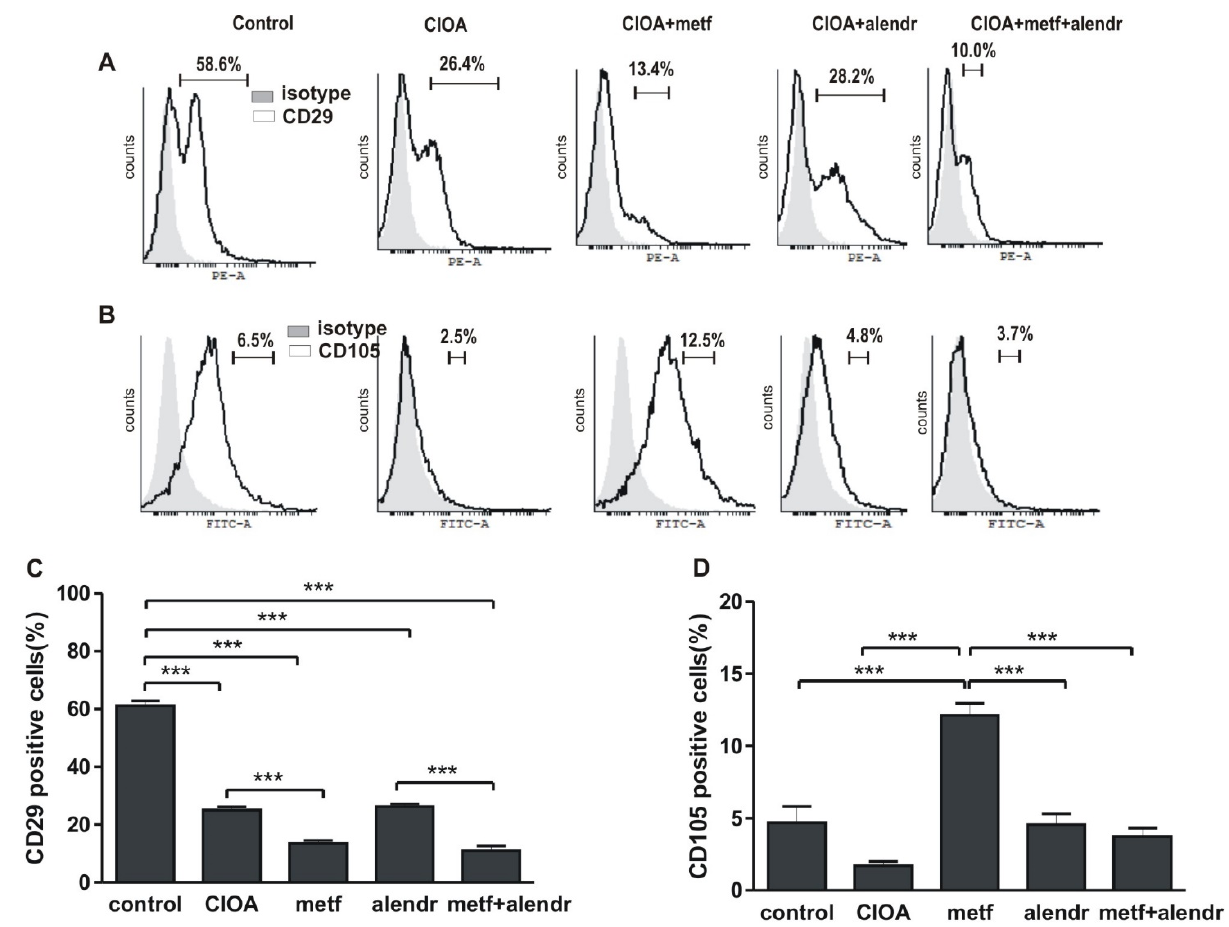
Figure 2. Flow cytometry data. ( A ) Percentage of CD29+ fibroblast-like cells. ( B ) Percentage of CD105+ mesenchymal cells. ( C ) Figure data of ( A ). ( D ) Figure data of ( B ). Data are means ± SD from three determinations ( n = 10 per group). *** p < 0.001, one-way ANOVA. (CIOA = collagenase-induced osteoarthritis; metf = metformin; alendr = alendronate).